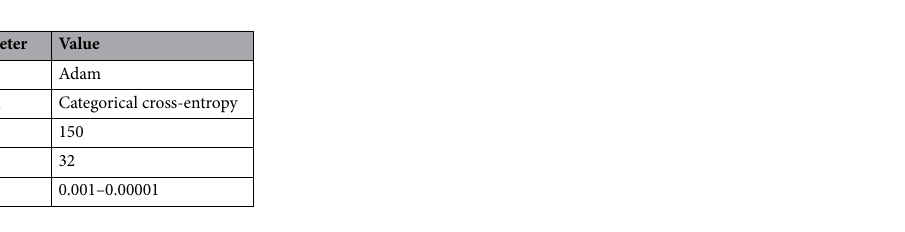
Table 3. CNN model’s hyperparameters